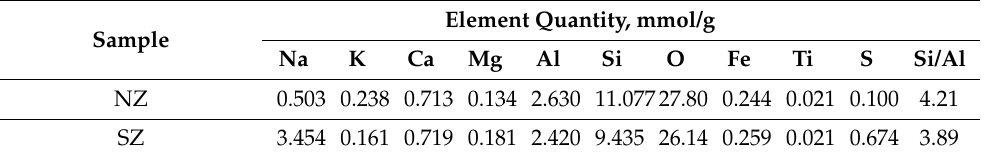
Table 2. Element quantity of NZ and SZ.